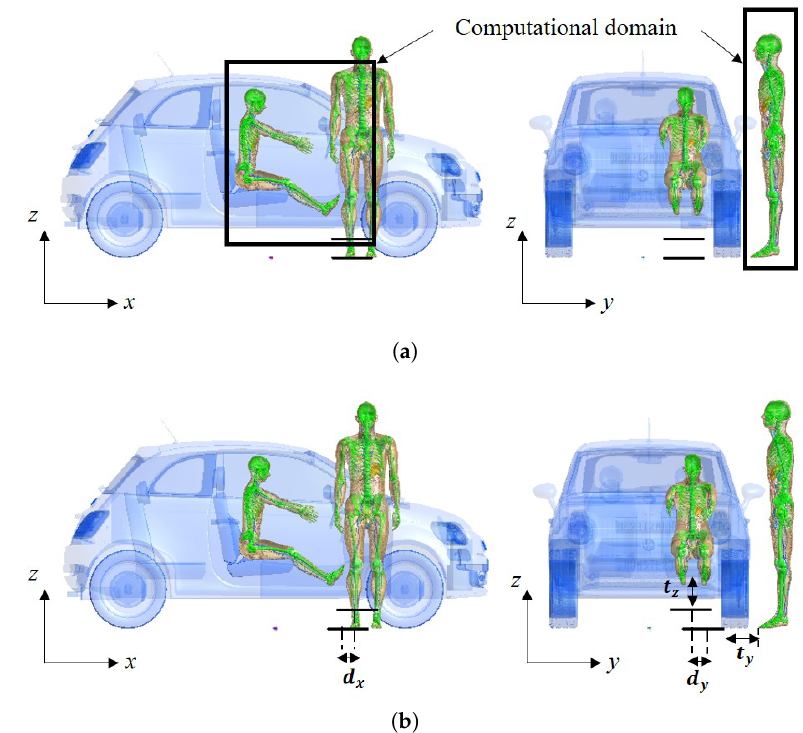
Figure 3. Exposure scenarios for the aligned ( a ) and misaligned ( b )